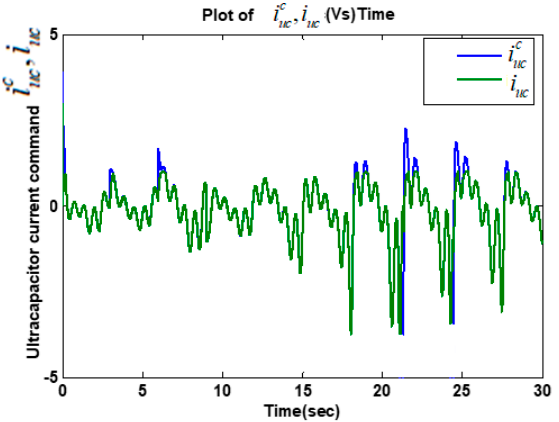
c ( t )( A ) and current i uc ( t )( A ) . Energies 2020 , 13 , x FOR PEER REVIEW uc